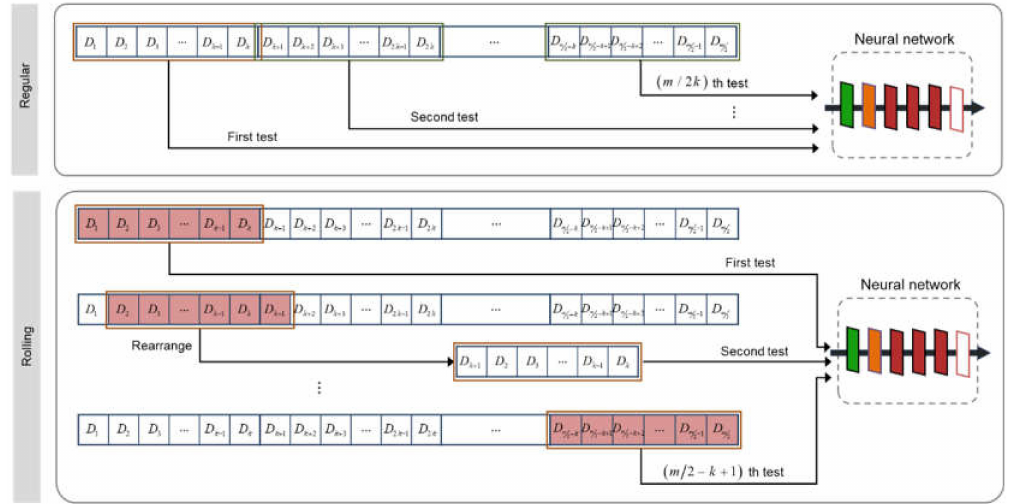
Figure 8. Diagram of data rolling utilization approach for the differential